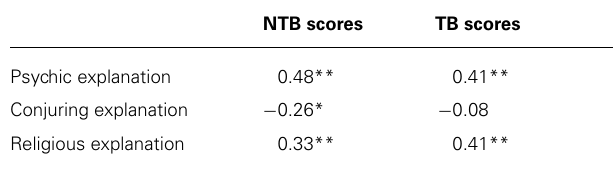
Table 2 | Pearson correlation coefficients when correlating belief scores (NTB,TB), as assessed before the anomalous event, with the three explanation ratings for the event, as assessed after the anomalous event (* p < 0.05; ** p <